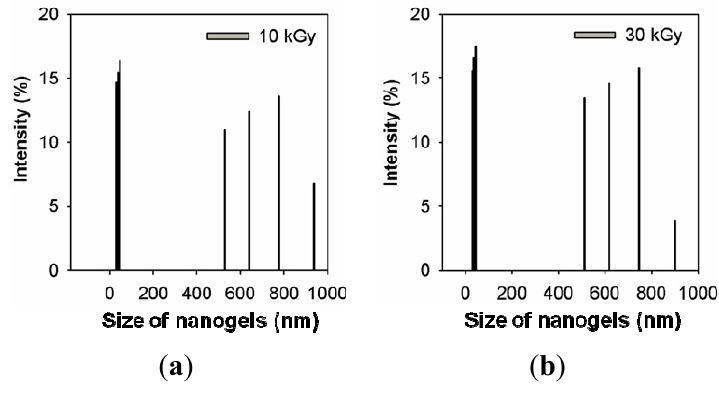
Figure 3. The size distribution of Ag/PAAc nanogels; PAAc 1 wt%, hexane 3 wt% AgNO